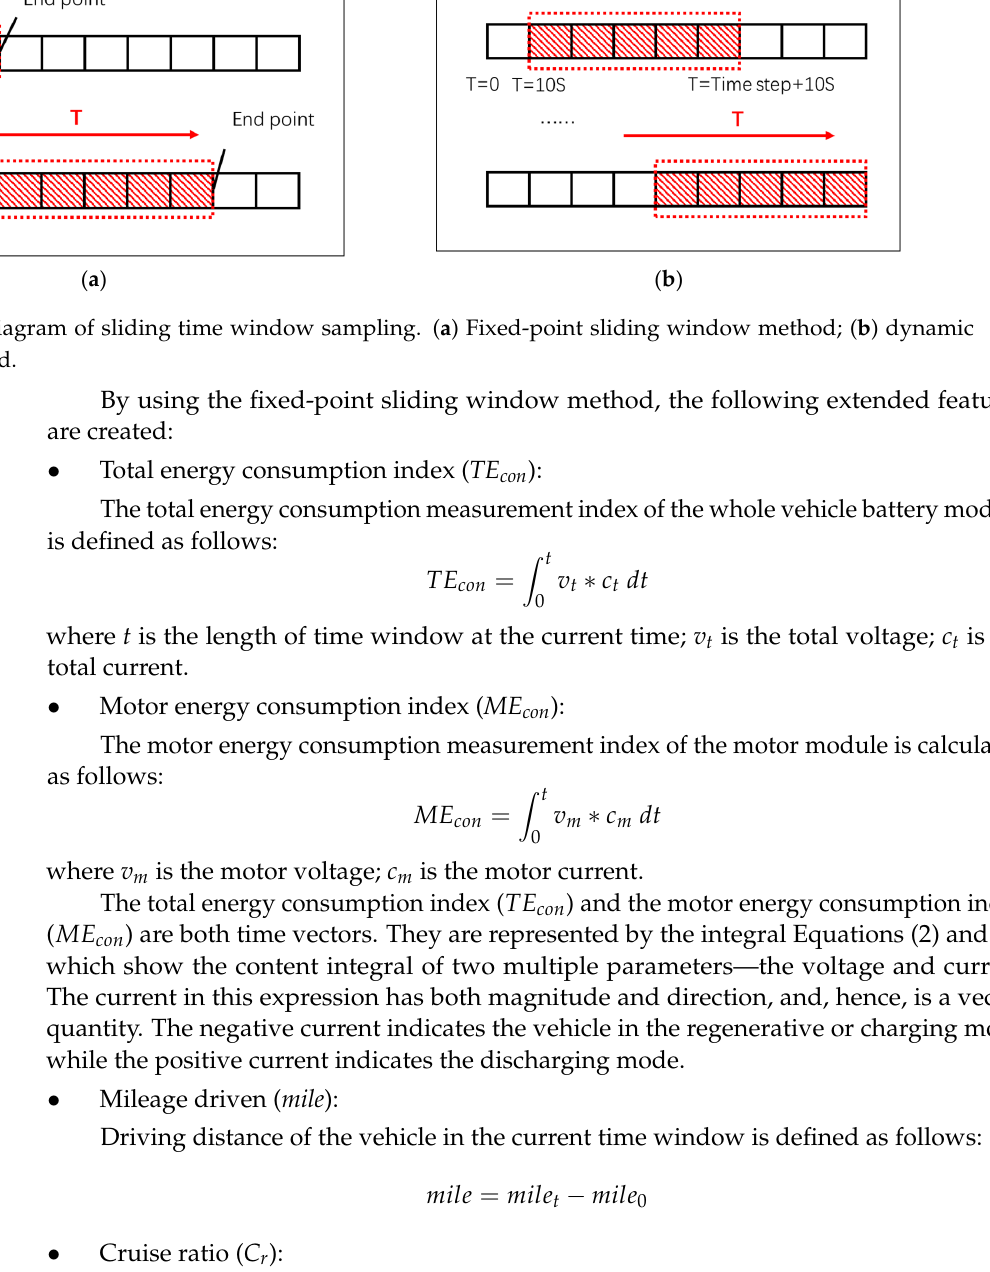
Figure 2. The correlation of the original features.